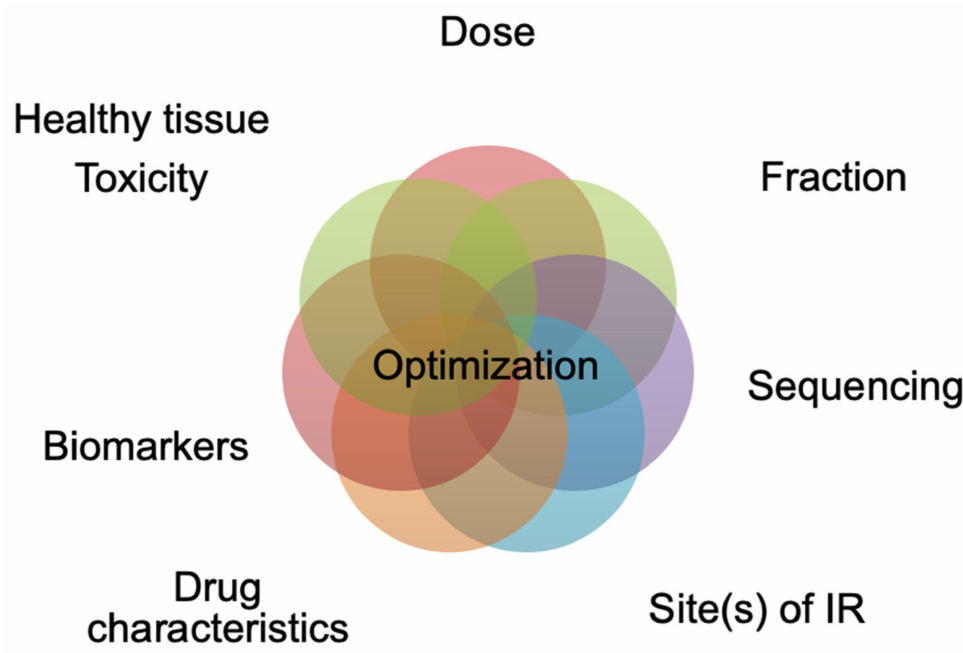
Figure 1. Ongoing challenges of radiotherapy–drug